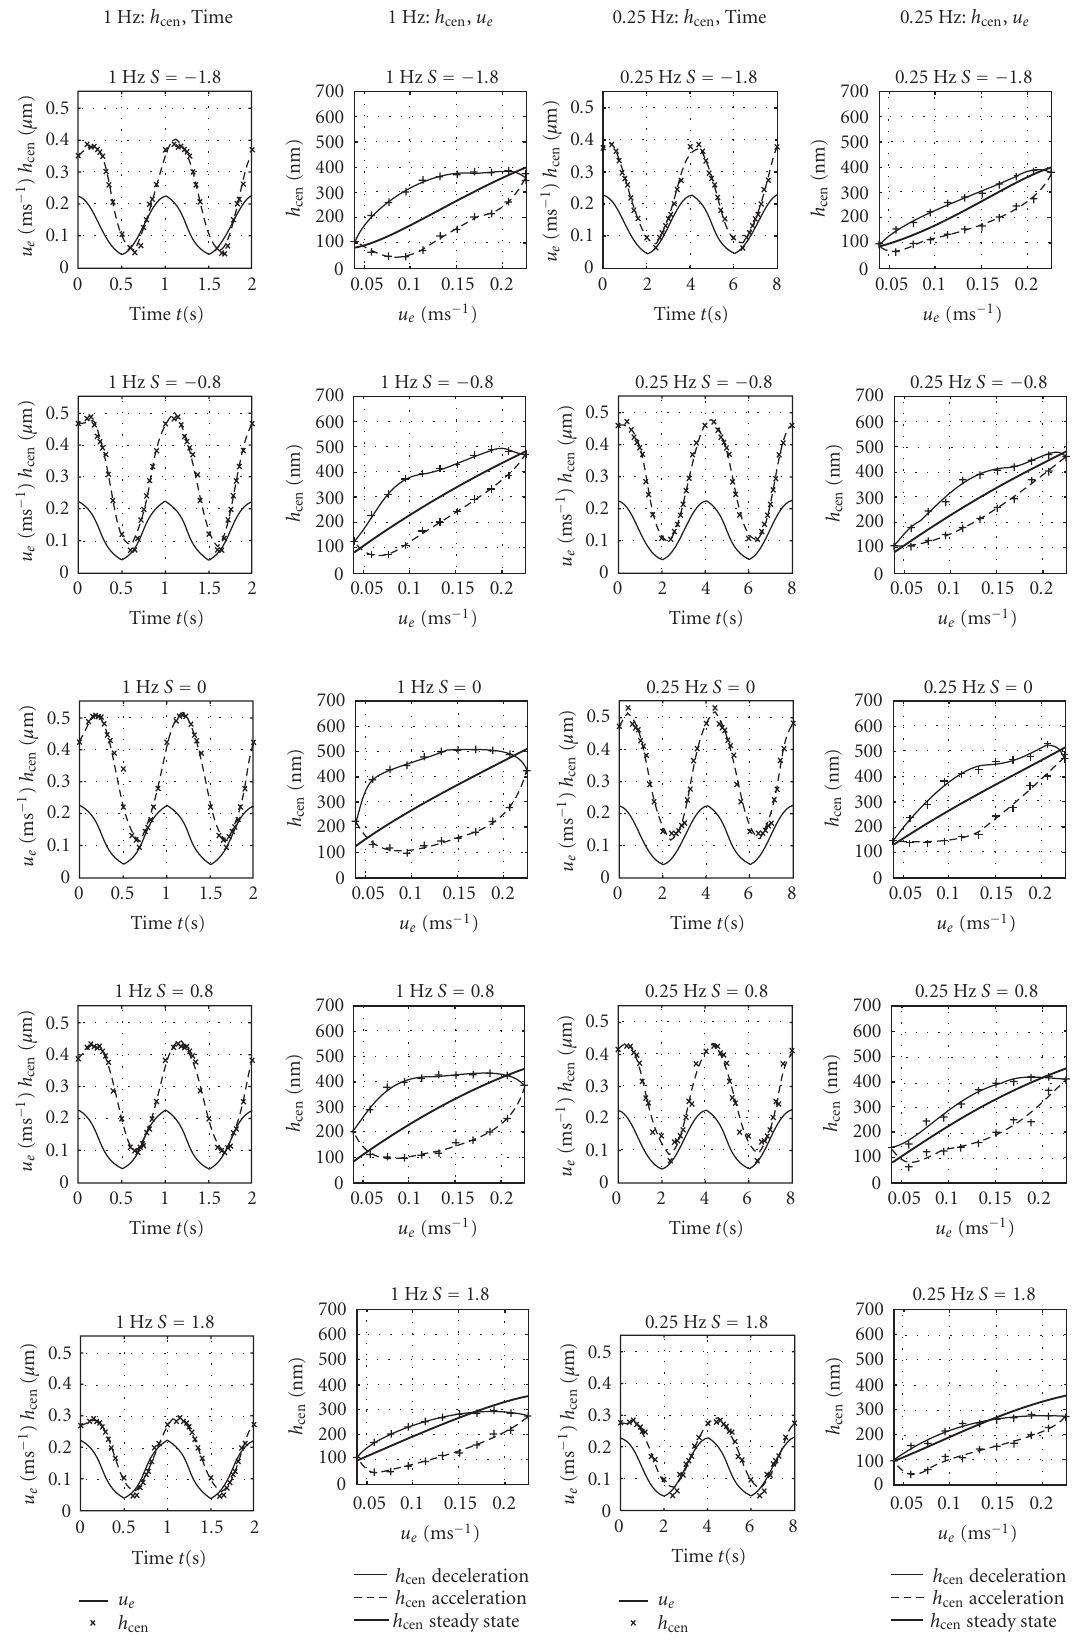
Figure 16: Central film thickness as a function of time and entraining velocity for the two test frequencies 1Hz and